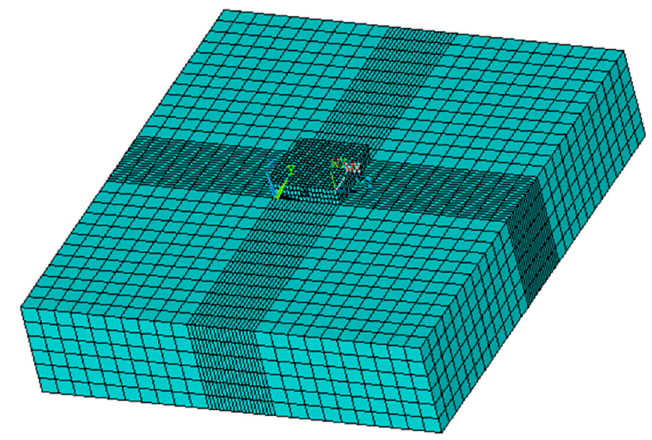
Figure 2. The single-layer finite element model.